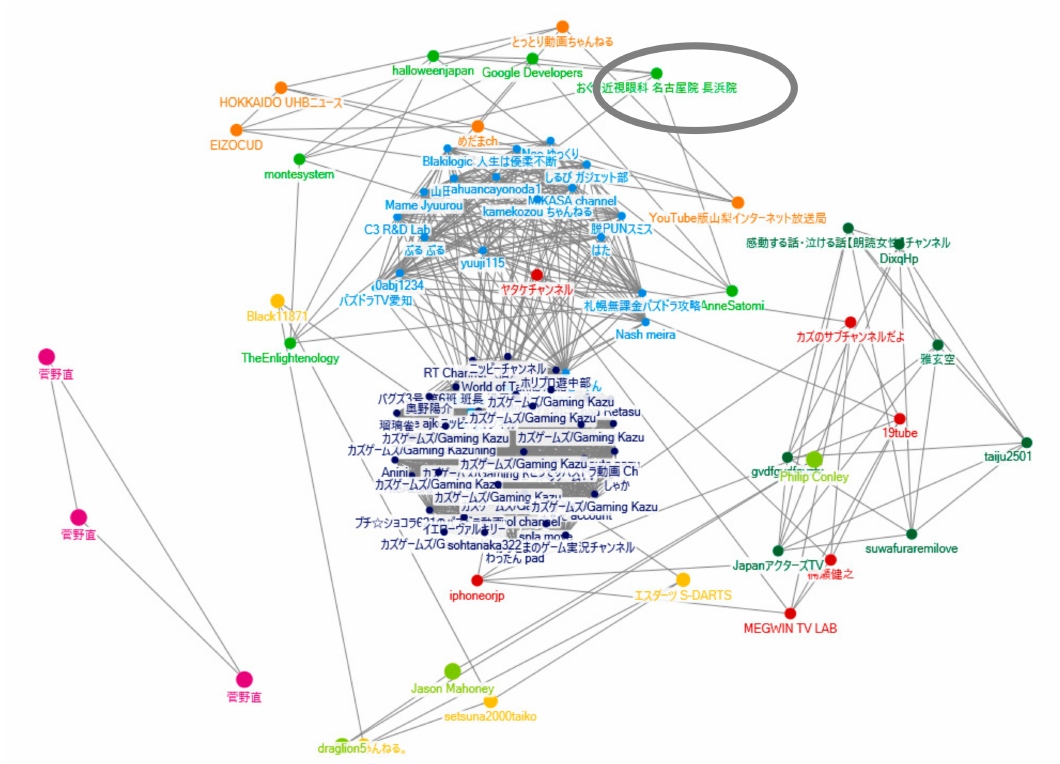
Figure 4. Node XL network regarding the “color vision support function” (shikikaku sap¯oto